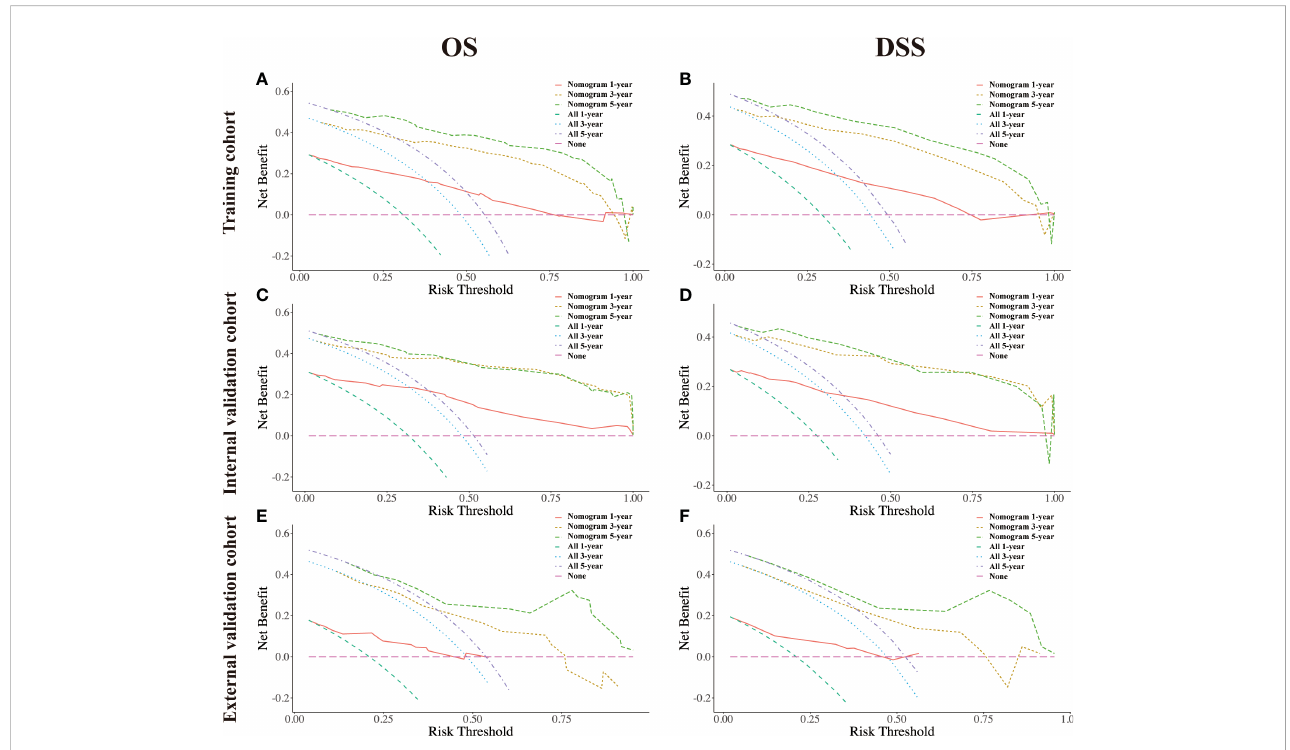
FIGURE 9 The decision-curve analysis (DCA) plots of the nomogram of CRNENs for 1, 3, and 5-year OS rates in the training cohort (A) , the internal validation cohort (C) , and the external validation cohort (E) . The decision-curve analysis (DCA) plots of the nomogram of CRNENs for 1, 3, and 5-year DSS rates in the training cohort (B) , the internal validation cohort (D) , and the external validation cohort (F) . CRNENs, colorectal neuroendocrine neoplasms; OS, overall survival; DSS, disease-speci fi c survival. Note: “ All ” refers to intervention for all, and “ None ” refers to intervention for none. Intervention is considered to be any behavioral or external factor considered by high-risk patients when obtaining positive results from the